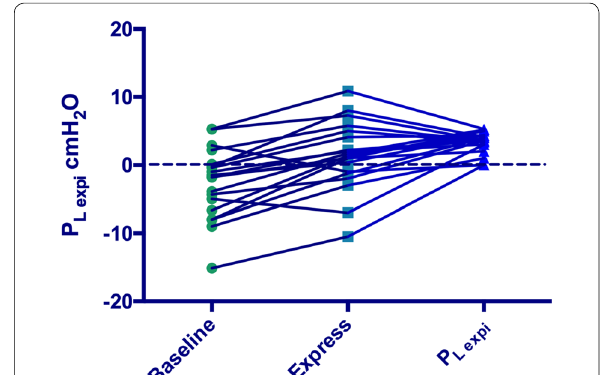
Fig. 2 Individual P Lexpi levels according to baseline, Express and P Lexpi protocols. P Lexpi positive end‑expiratory transpulmonary pressure. = Dash line represents the limit of 0 cmH 2 O; more patients had negative P Lexpi with the Express protocol